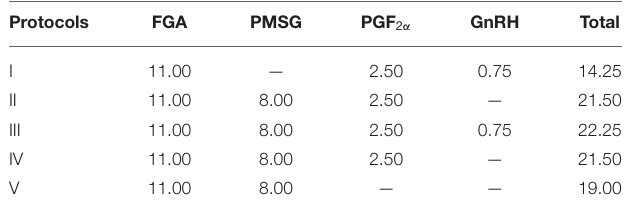
TABLE 3 | Drug cost of estrus synchronization of single ewe of five protocols (CNY).